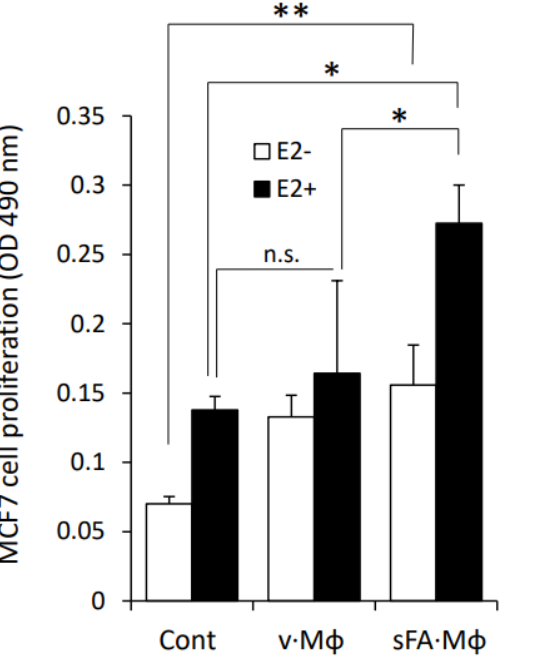
Figure 4. Effect of SFA-stimulated macrophages on estrogen sensitivity of MCF7 cells. Prior to es- trogen treatment, MCF7 cells were maintained for 2 weeks in phenol red–free medium supplemented with charcoal-stripped FCS (5%), and then incubated (96 h, 37 ◦ C) with the medium conditioned by either unstimulated macrophages (Cont), or macrophages stimulated (16 h) by vehicle (BSA) alone (v · M φ ) or by 200 µ M palmitate (SFA) conjugated with fatty acid free-BSA at a 2:1 molar ratio (SFA · M φ ), in the absence (white bars) or presence (black bars) of 10 − 9 M estradiol (E2). Cell prolif- eration was analyzed by MTS assay, * p < 0.02, ** p < 0.003; n.s: no statistical difference. Error bars represent ±